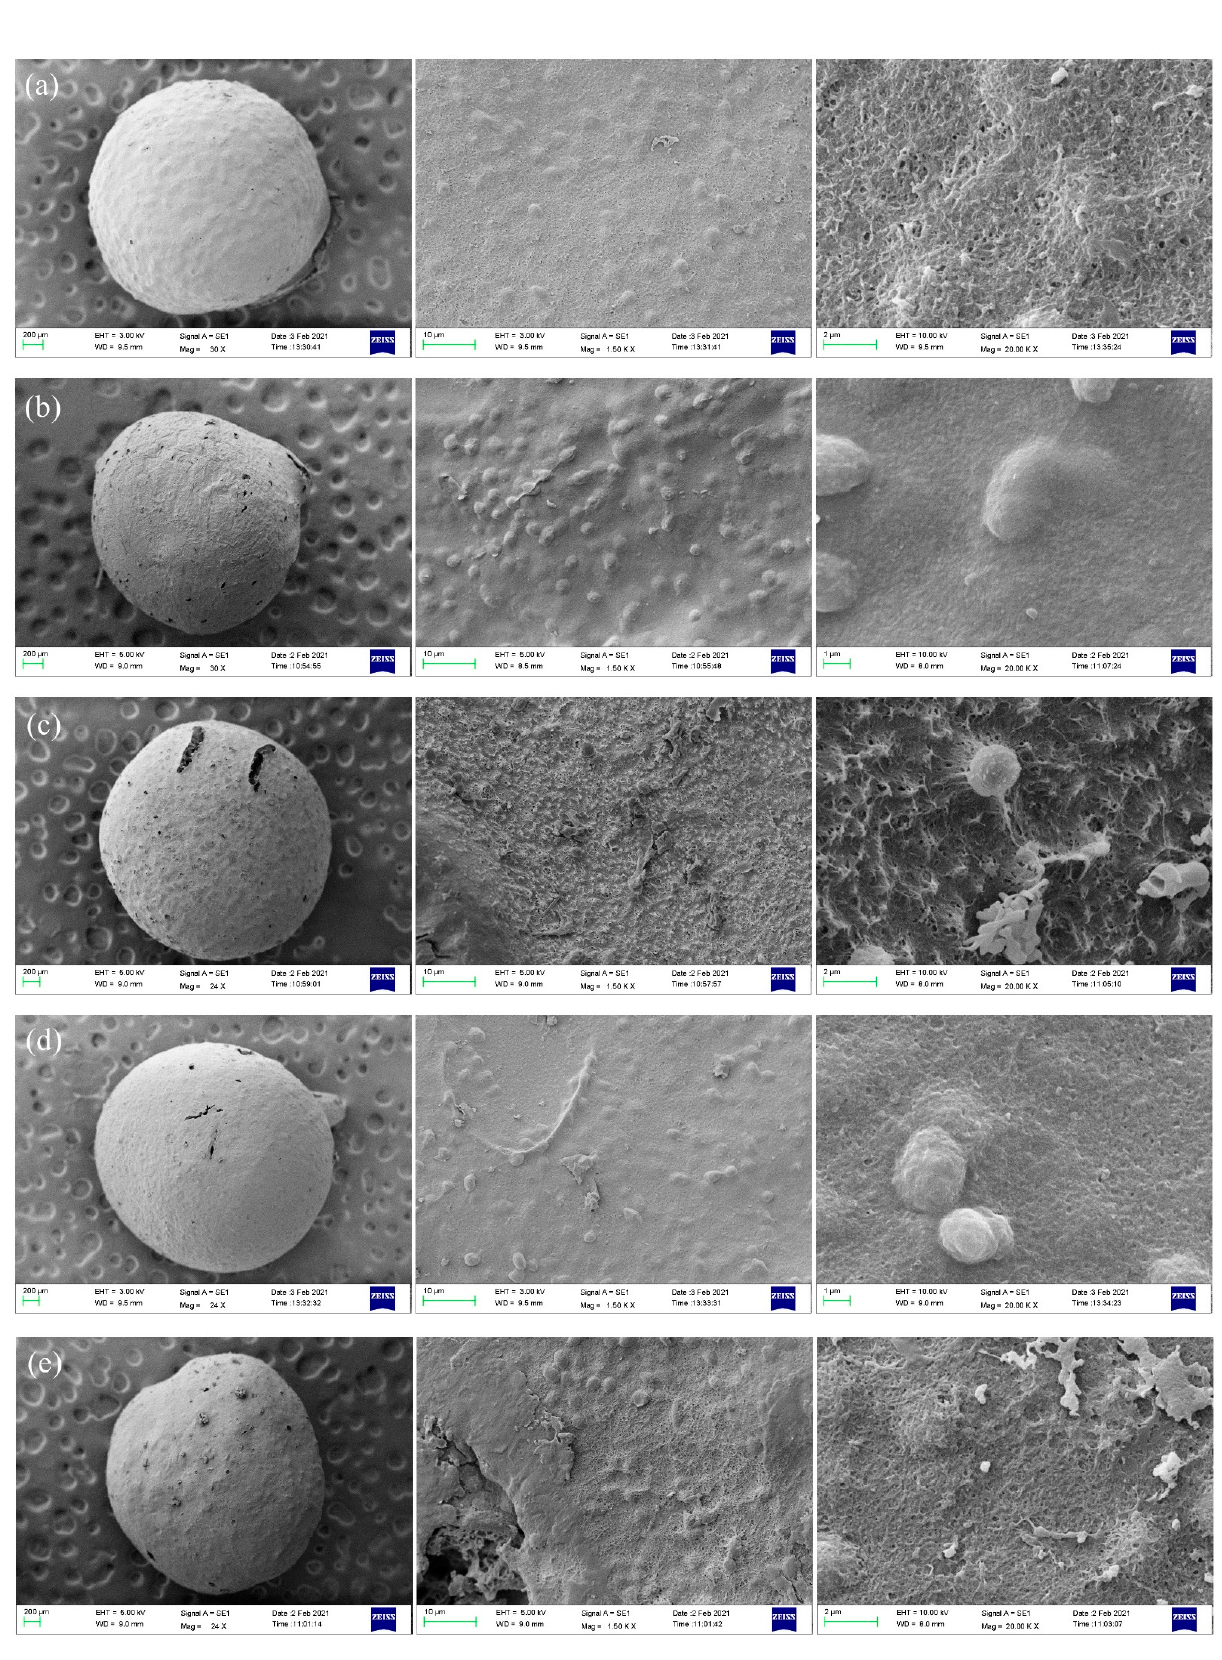
Figure 4. SEM images of the porous chitosan/saccharomycetes microspheres with different ratio of chitosan to saccharomycetes and silica gel of 1:1:1 ( a ), 1:2:1 ( b ), 1:2:2 ( c ), 1:2:3 ( d ) and 1:2:4 ( e ).